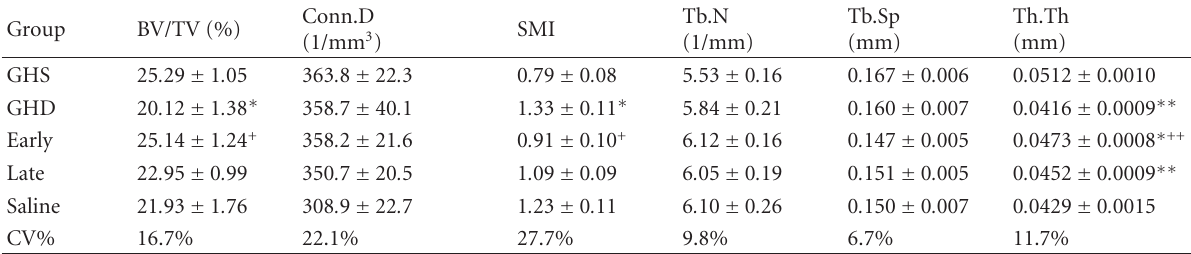
Table 2: Vertebral trabecular microarchitectural parameters including bone volume ratio (BV/TV), connectivity density (Conn.D), structure model index (SMI), trabecular number (Tb.N), trabecular separation (Tb.Sp), and trabecular thickness (Tb.Th) in GH-su ffi cient (GHS), GH deficient (GHD), early treatment (early; daily GH injections from age 21 to 60 days), late treatment (late; daily GH injections from age 35 to 60 days), and saline control (saline; daily saline injections from age 21 to 60 days). Mean and standard errors are reported, and the coe ffi cient of varation (CV%). ∗ P ≤ 0 . 05, ∗∗ P ≤ 0 . 001 versus GHS, + P ≤ 0 . 05, ++ P ≤ 0 . 001 versus GHD.